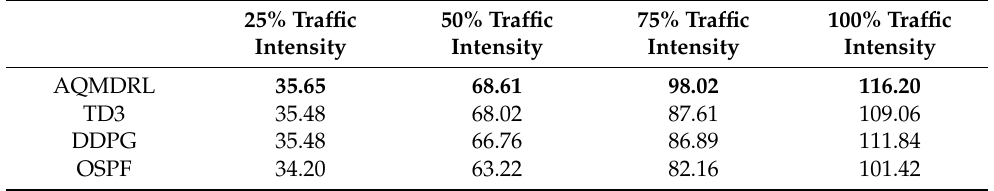
Table 4. Comparison of average throughput in different traffic intensities